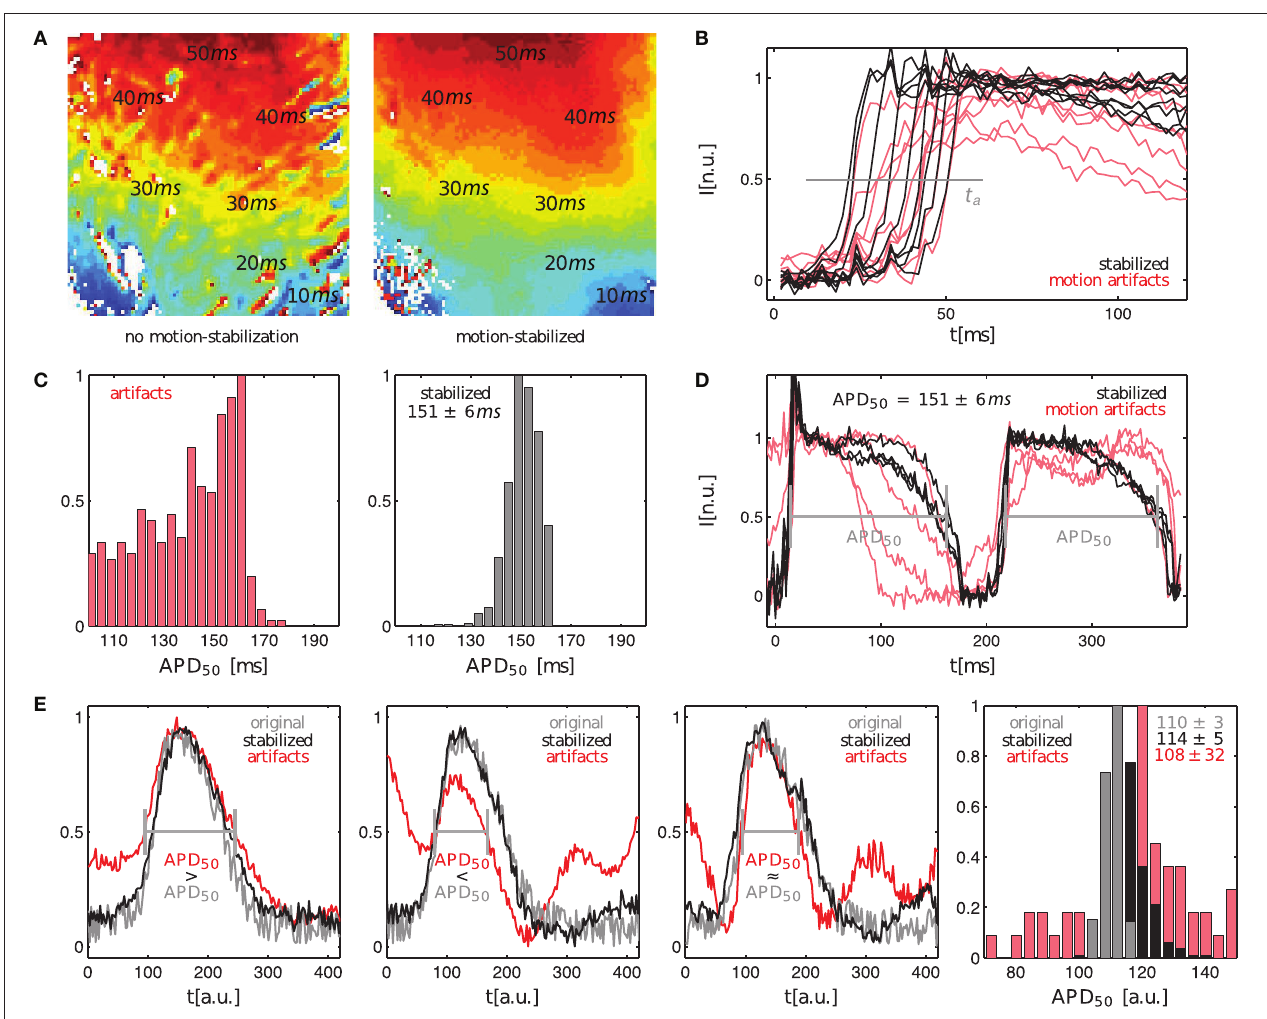
FIGURE 6 | Comparison of activation time and action potential duration measurements in optical maps with and without motion artifacts. (A) Activation maps showing quasi-planar action potential wave propagation on left ventricular surface of contracting rabbit heart before tracking and without motion-stabilization (left) and after tracking and with motion-stabilization and motion artifact compensation (right). (B) Upstroke detection (at 0.5) for computation of activation maps in (A) . (C,D) Action potential duration measurements of < APD 50 > = 151 ms ± 6 ms for motion-stabilized video data. Variance in action potential duration due to motion decreases with motion compensation. (E) Comparison of uncertainty in action potential duration measurements in original artifact-free data (APD 50 = 110 ± 3 a . u .) and tracked, motion-stabilized synthetic video data (APD 50 = 114 ± 5 a . u .). Uncertainties without motion or motion compensation are both σ APD < 5 % and are much larger with